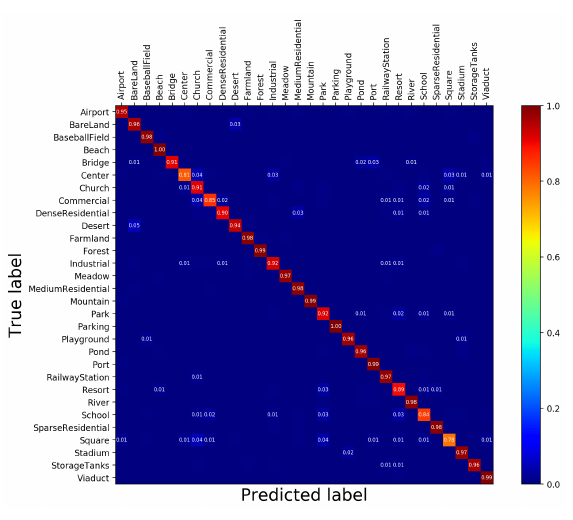
Figure 5. The classification performance of different regulator settings on 20% and 50% AID dataset. The number of parameters is marked below the blue